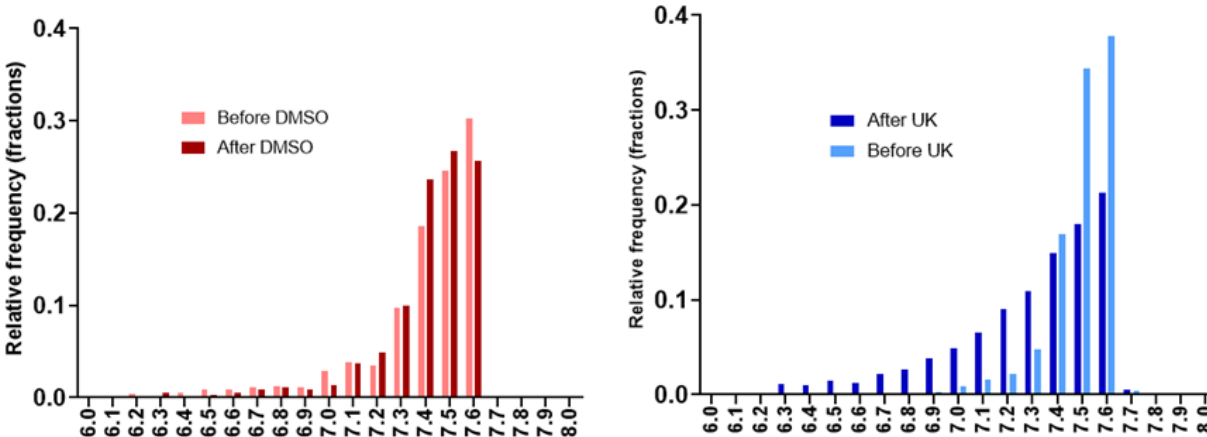
DMSO group and n = 8 in the UK-5099 group).